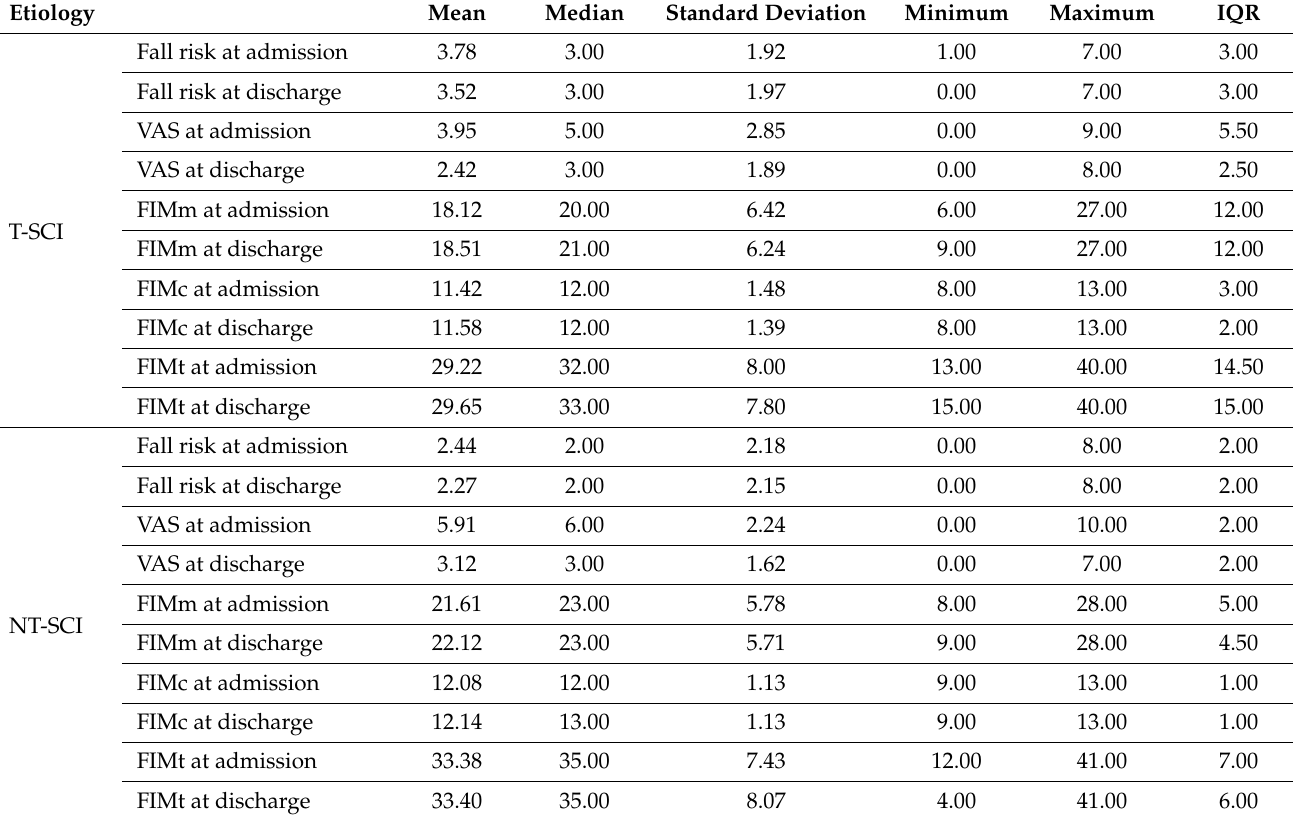
Table 2. Clinical–functional parameters of T-SCI/NT-SCI.